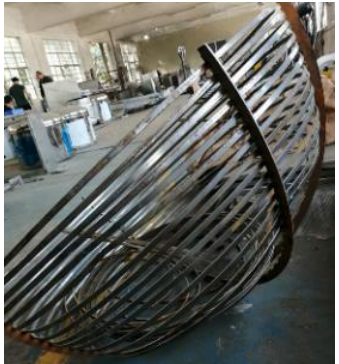
Figure 9. Error in processing.